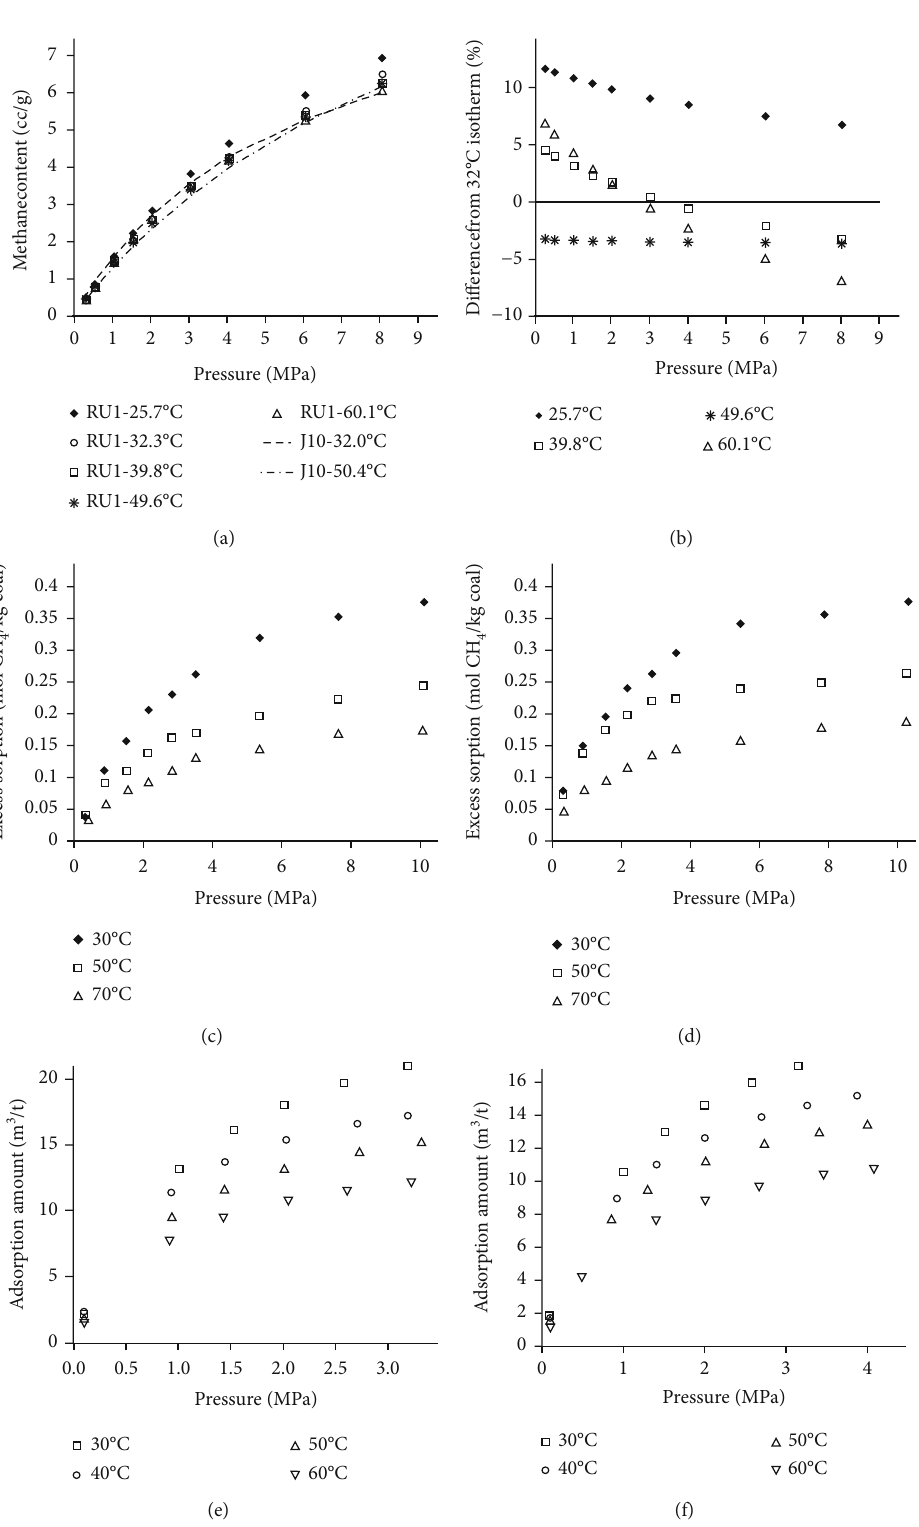
Figure 16: Variations of gas adsorption behavior with temperature in coal reservoirs: (a) methane adsorption isotherms for the 96% RH (equilibrium moist) samples at a variety of temperatures; (b) percent di ff erence from the 32 ° C (bed temperature) isotherm for the various temperatures of the RU1 samples in (a); (c) adsorption isotherms of the weak-brittle deformed coal at di ff erent temperatures; (d) adsorption isotherms of the strong-brittle deformed coal at di ff erent temperatures; (e, f) adsorption curves at di ff erent temperatures for samples (modi fi ed from Crosdale et al. [107], Pan et al. [108], and Liu et al.